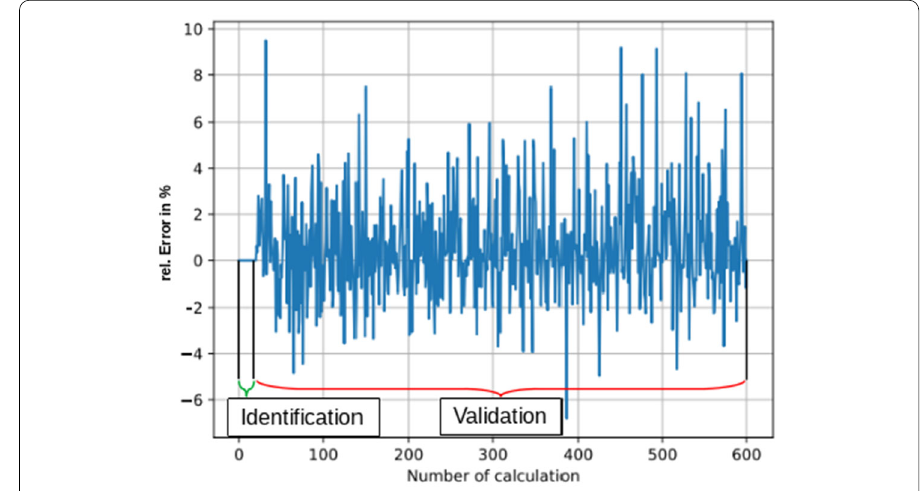
Fig. 12 Rel. error for brakedisk. odf = 1 Plot of the rel. error of the brakedisk with odf = 1